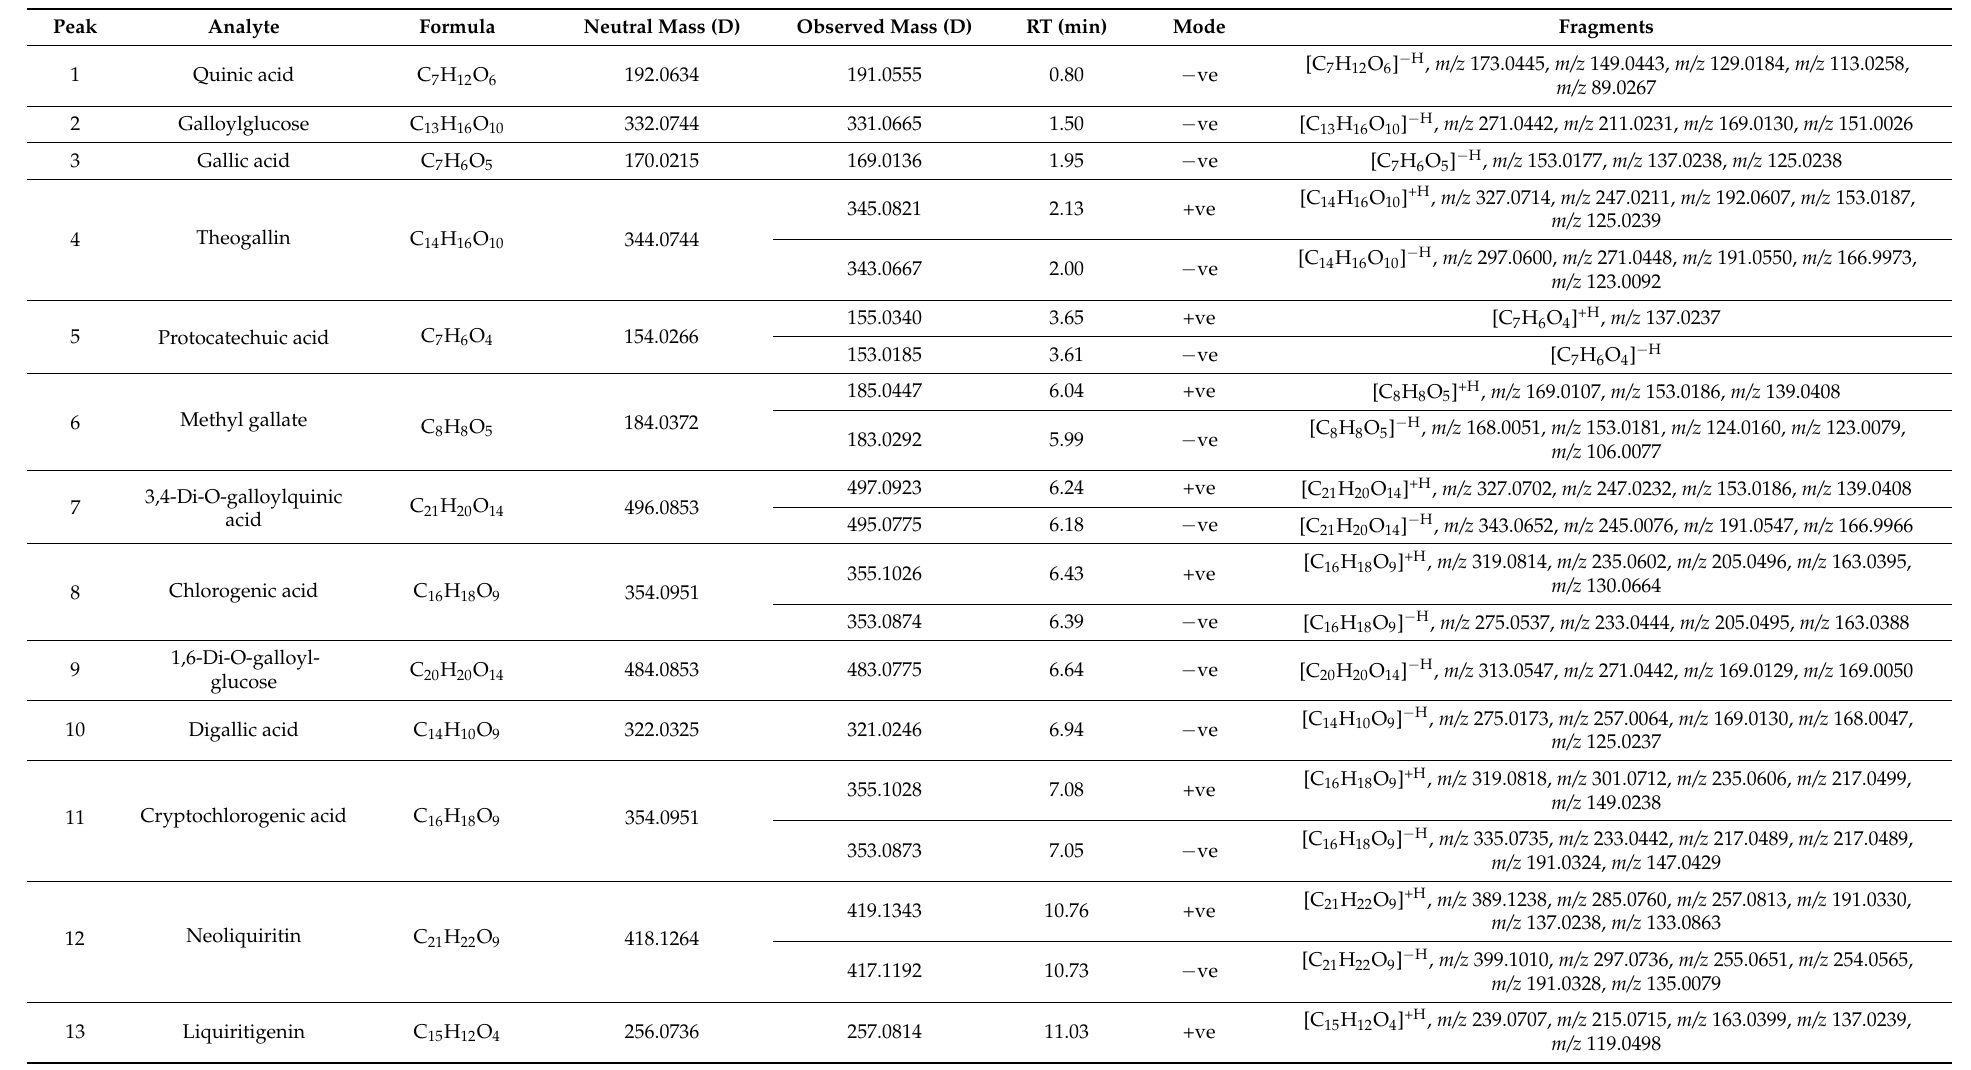
Table 2. Identified metabolites in Divya-Swasari-Vati (DSV) on UPLC/QToF MS